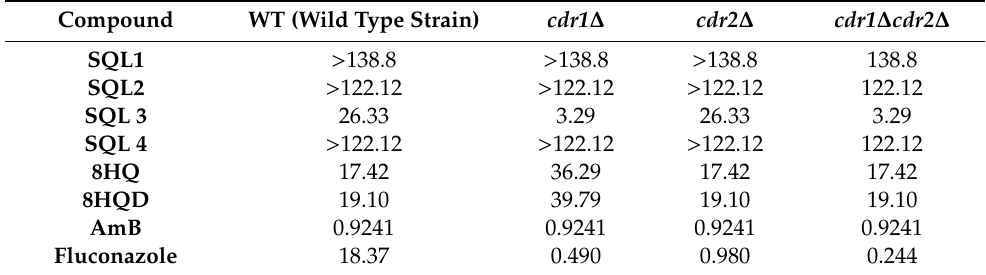
Table 1. The minimum inhibitory concentration (mg / L) at which 50% of isolates were inhibited (MIC50) for tested styrylquinoline compounds and amphotericin B (AmB) ( n = 3).